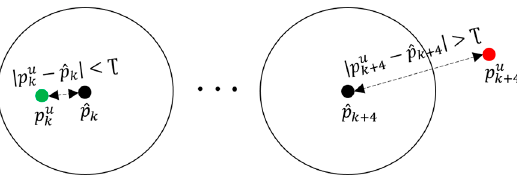
Figure 7. Result of implemented stance phase detection.